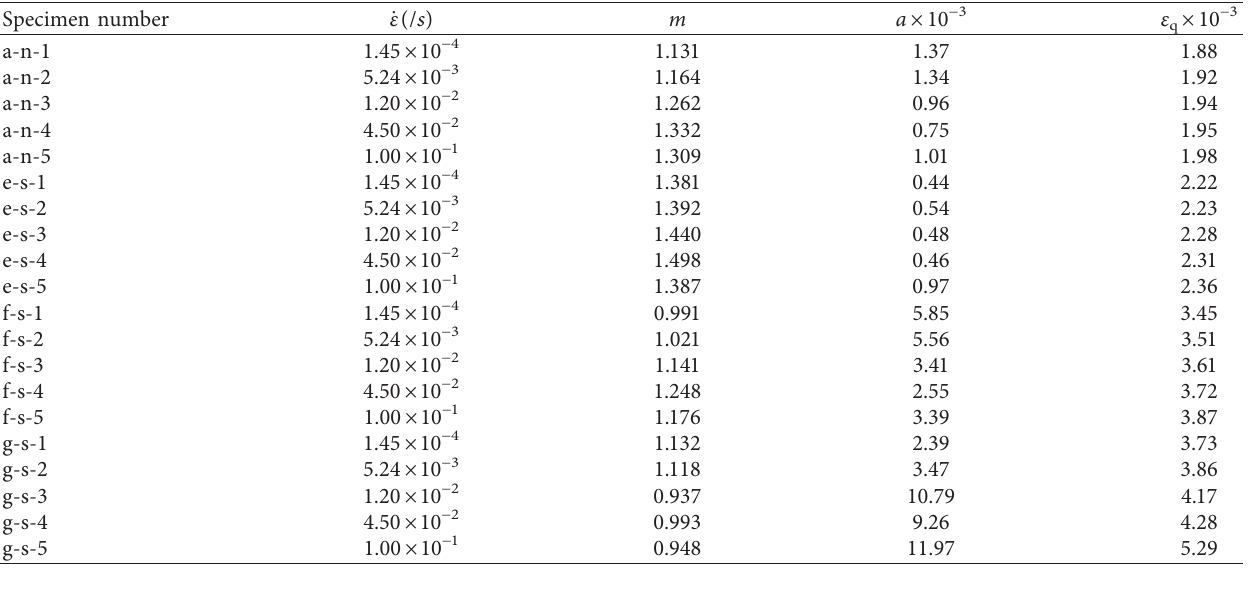
Table 8: Damage parameters of SFRC.